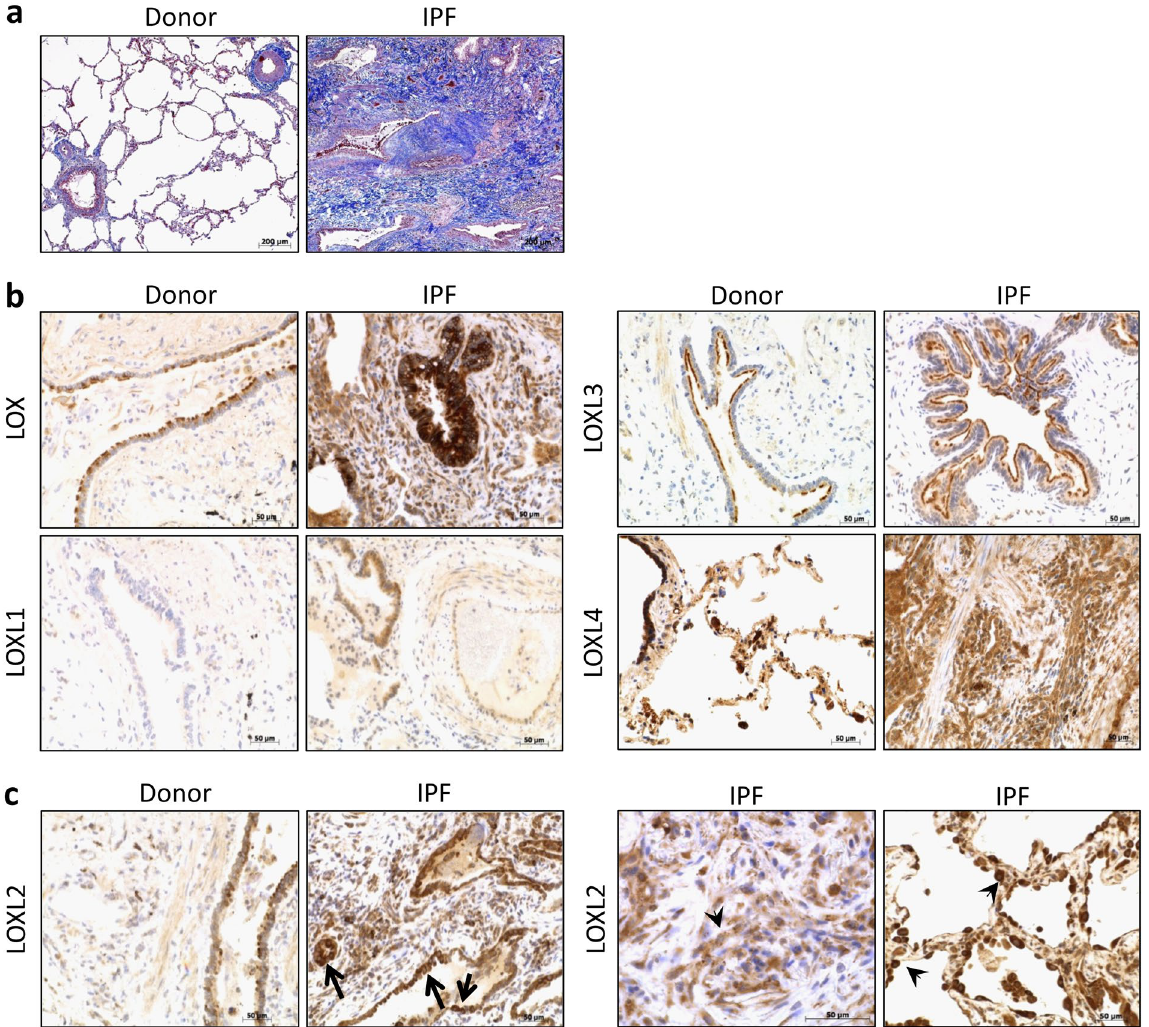
Figure 4. LOX/L expression in human IPF lungs. ( a ) Masson trichrome stained histological sections of donor and IPF patient lung tissue. Nuclei appear in dark red, cytoplasm in light red and collagen in blue (scale bar = 200 µ m ). ( b ) Expression of LOX, LOXL1, LOXL3 and LOXL4 in IPF and donor lungs. Representative pictures of immunohistochemistry in tissue specimen of patients with IPF and transplant donors are shown. Positive cells are depicted in brown (scale bar = 50 µ m ). ( c ) Immunohistochemistry of LOXL2 in tissue specimen of patients with IPF and transplant donors. LOXL2 in bronchial epithelium is marked with black arrows. LOXL2 expression in hyplerplastic alveolar epithelial cells in the interstitial region and fibroblast foci are indicated by arrow heads (scale bar = 50 µ m